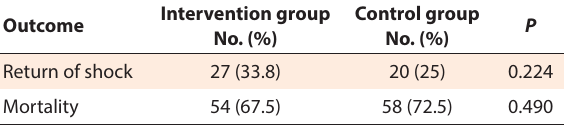
Table 2. Outcome in intervention and control groups Intervention group Outcome No. (%)